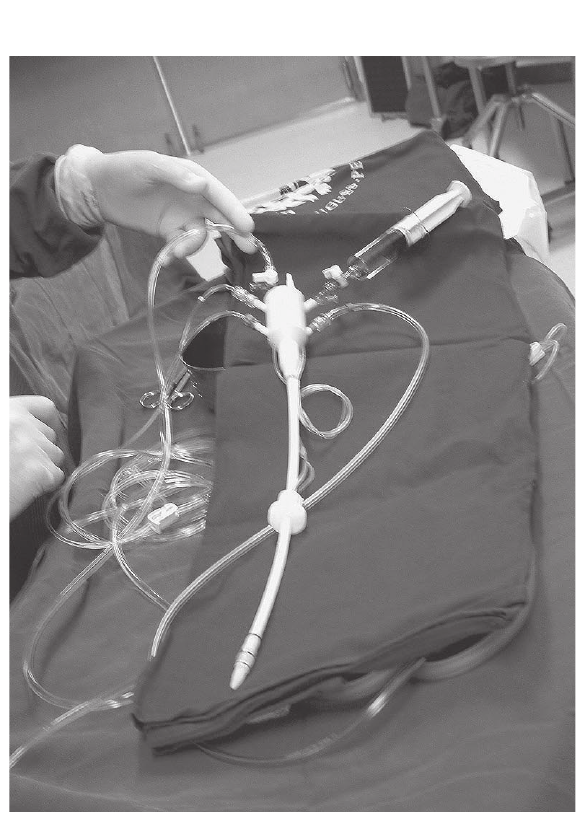
Fig. 1 - Cateter utilizado na descalcificação da valva aórtica com o coração parado.